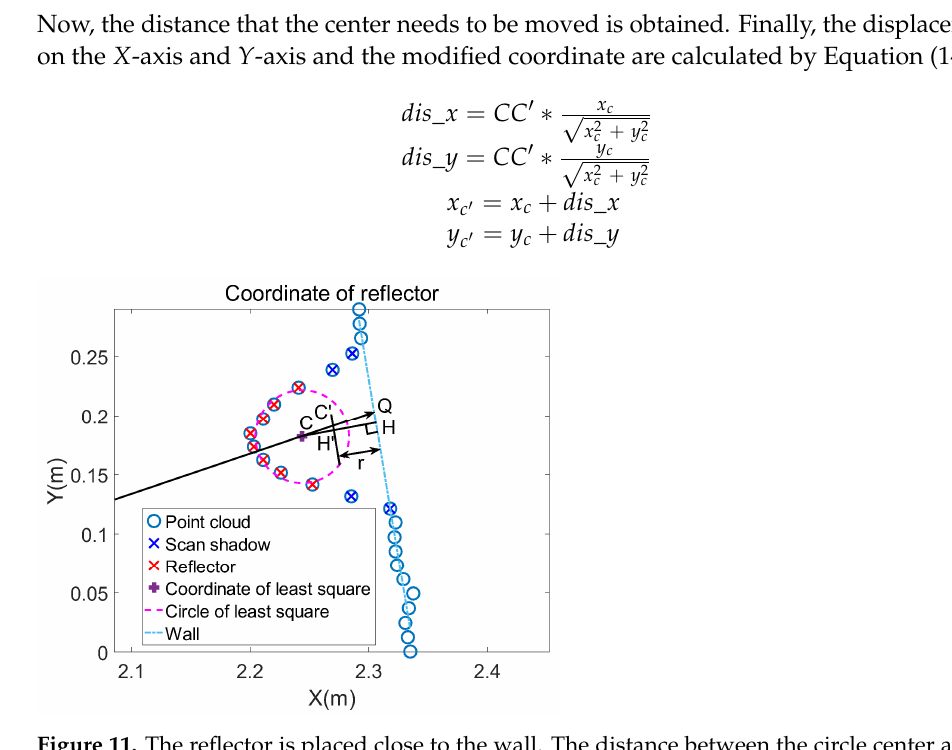
Figure 11. The reflector is placed close to the wall. The distance between the circle center and the wall equals the radius. Therefore, move the rough circle center to a point whose distance from the wall is radius.